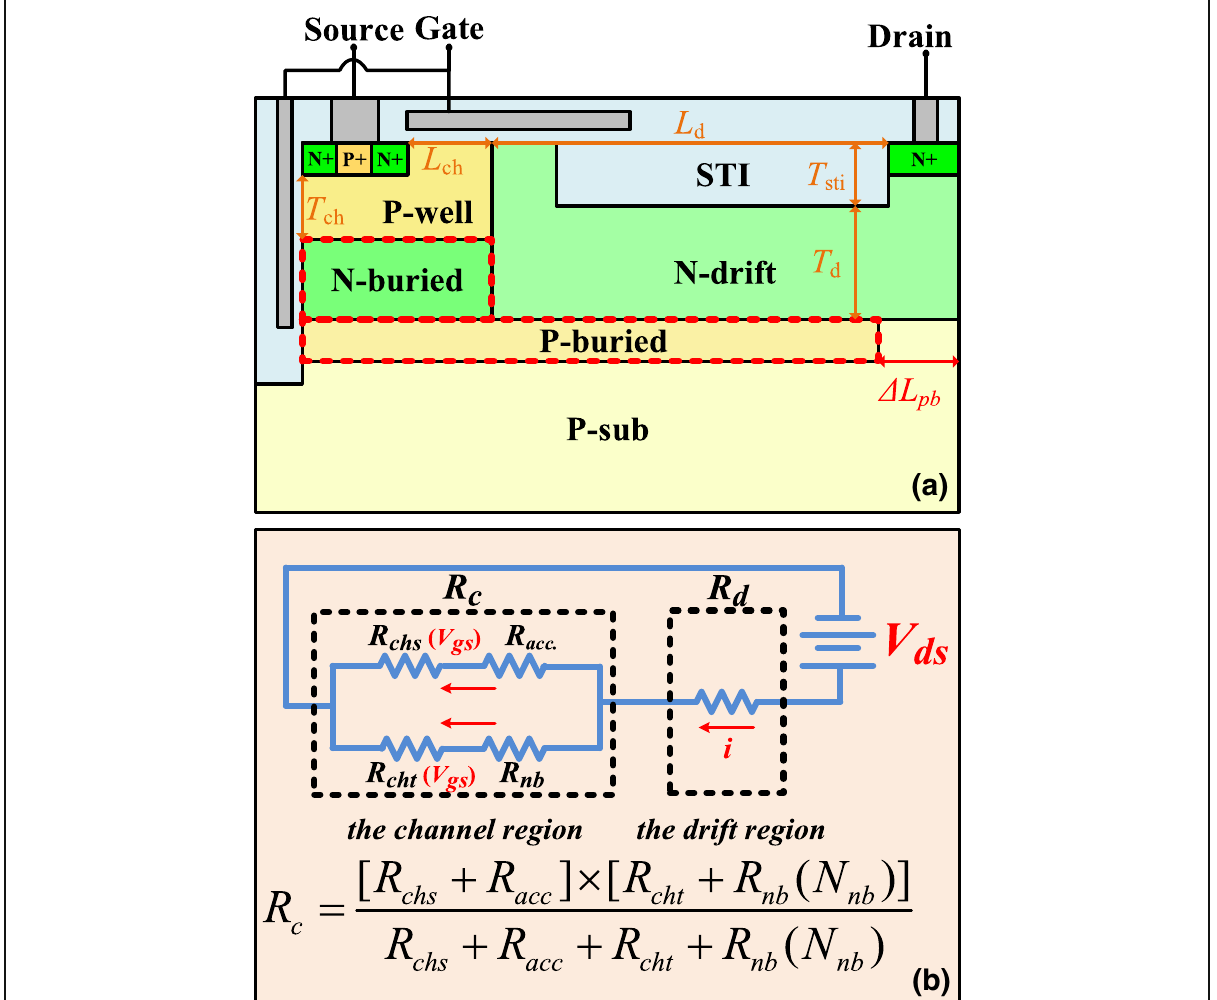
Fig. 1 a Schematic cross-section view of ultra-low specific on-resistance LDMOS with enhanced dual-gate and partial P-buried layer. b Schematic equivalent on-resistance for the proposed